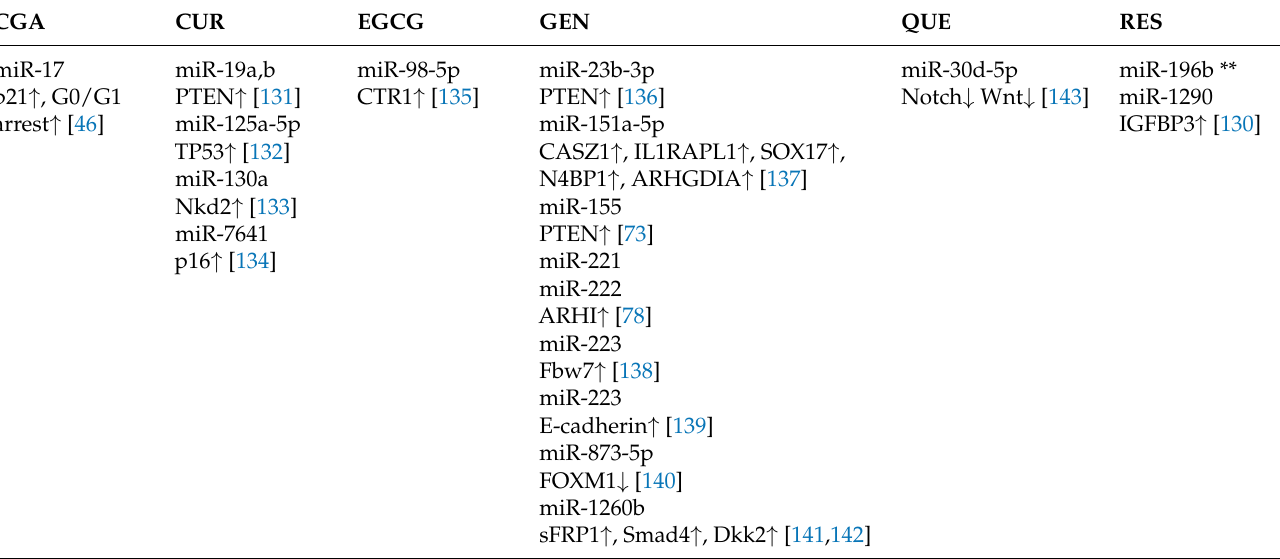
Table 4. miRs downregulated by one of six dietary polyphenols and their targets